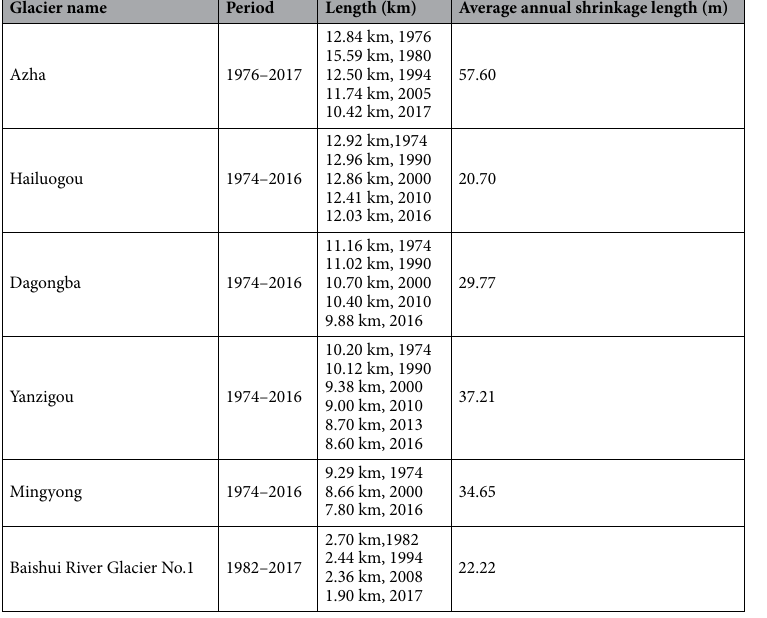
Table 2. Frontal retreat of six typical temperate glaciers for different